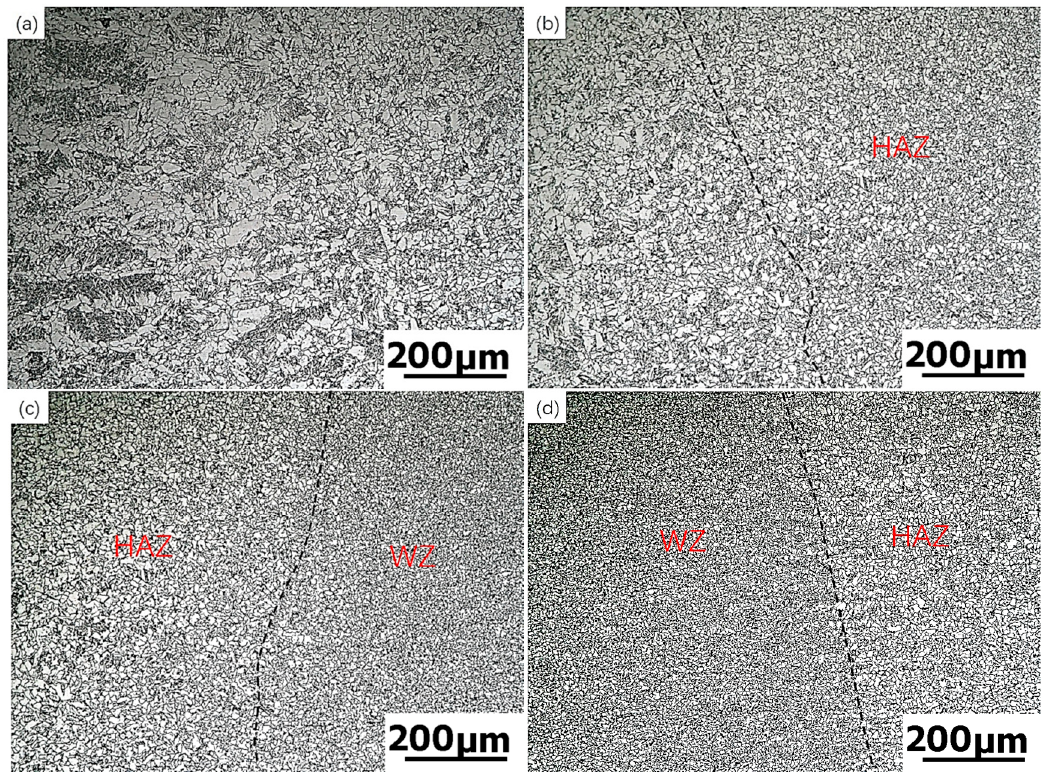
Figure 15. HAZ microstructure observation:( a ) base metal; ( b ) base metal and HAZ; ( c ) HAZ and welding zone; ( d ) welding zone and HAZ .